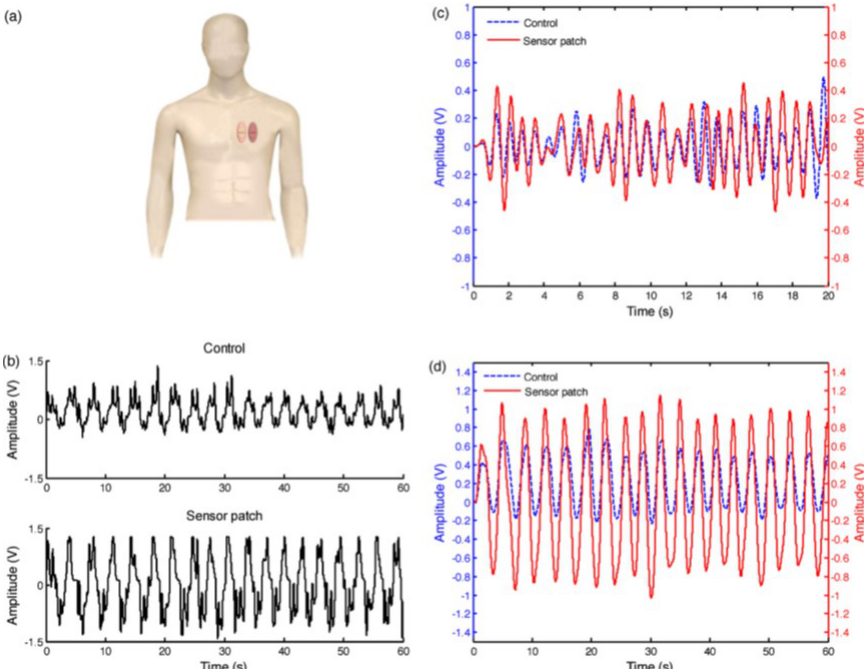
Figure 13. PVDF sensor for heartbeat and respiration detection. ( a ) Schematic representation of the adhesion of the PVDF sensor and control sensor patch on the chest wall of a human body. Comparison of the electrical signals obtained from the control sensor, and the proposed PVDF sensor: ( b ) raw electrical signals, ( c ) filtered signals for heartbeat detection, and ( d ) filtered signals for respiration detection. Reprinted with permission from [107] c (cid:13) 2013 Elsevier.